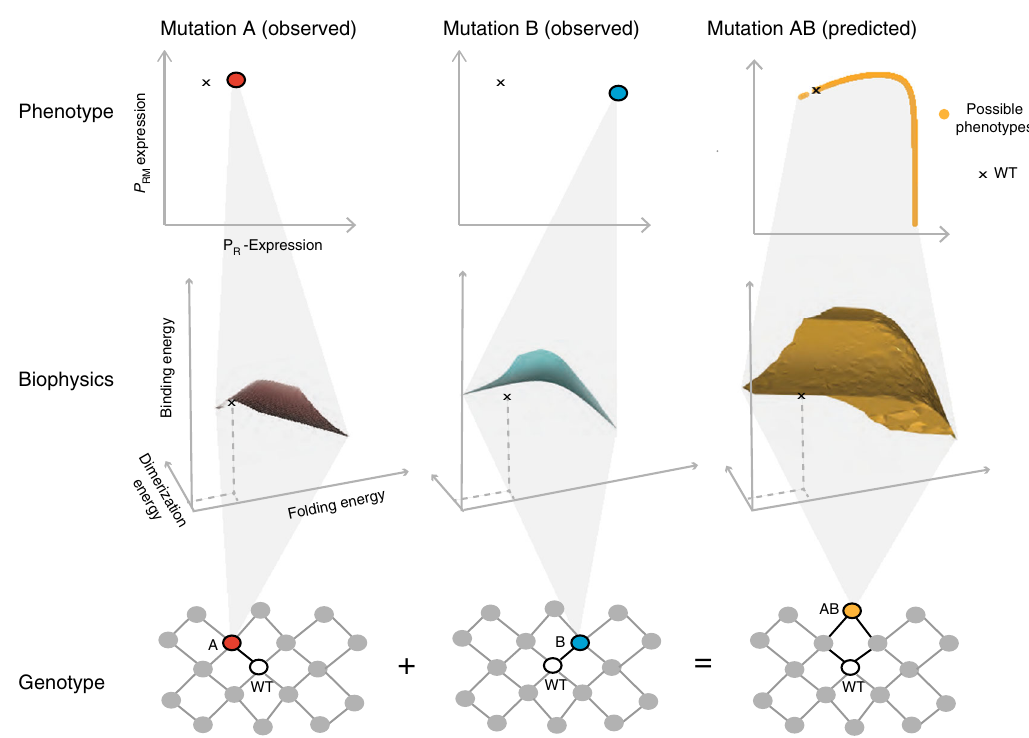
Fig. 5 Biophysical ambiguity as a hidden layer for phenotype prediction. Mutations can alter multiple biophysical properties to cause the same observed change in a phenotype. For example, the P R and P RM phenotypes of mutations A and B in CI could be caused by many different changes in three free-energy terms. When these two mutations are combined, the double mutant can have a phenotype spanning nearly the entire phenotypic range, depending upon what the hidden parameter changes are in each single mutant. Source data are provided as a Source data fi